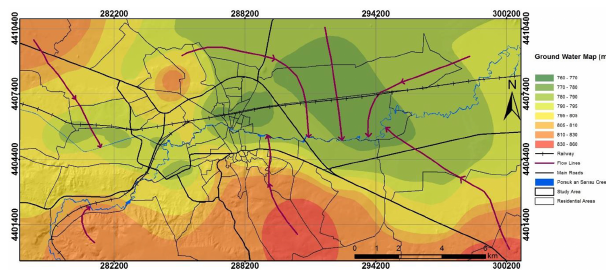
Figure 3. Groundwater table map obtained from the drill